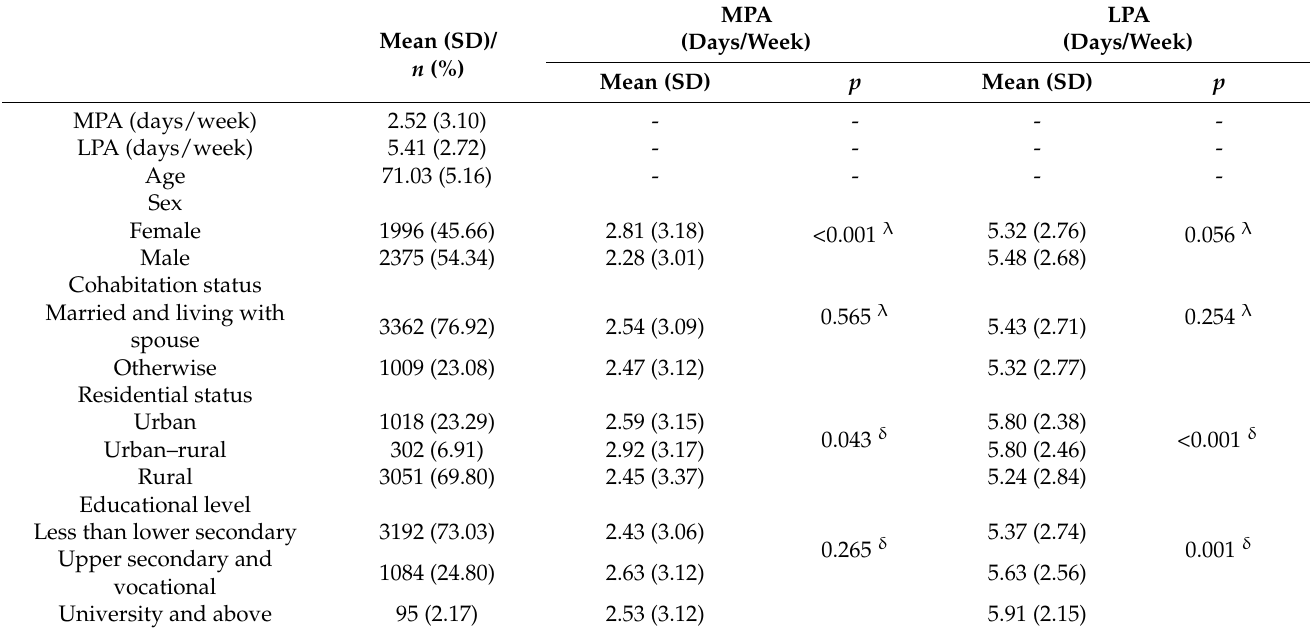
Table 1. Demographic characteristics of study subjects by physical activity intensity ( n =